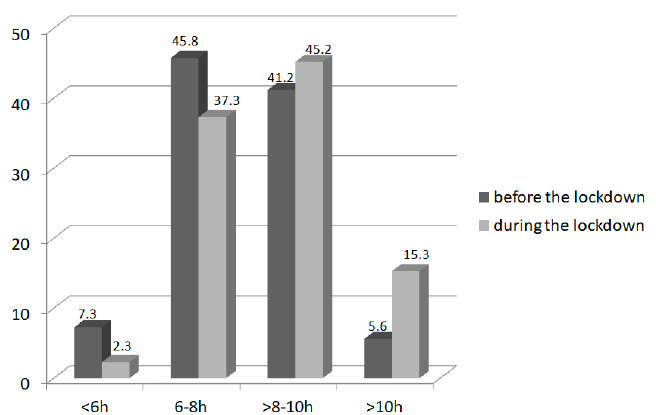
Figure 3. The length of the sleep (in hours per day) in children (n = 177) before and during the lockdown.